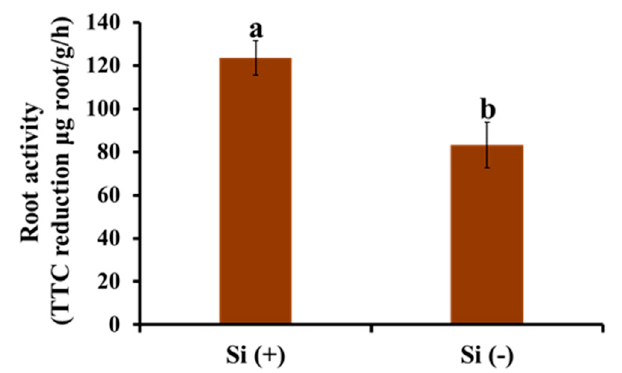
Figure 8. Effect of 30 days of silicon application on root activity in the coffee plants grown in plant growth chambers. Si (+) and Si ( − ) refer to 75 and 0 mg·L − 1 , respectively. Vertical bars indicate the means ± standard error ( n = 6). Different lowercase letters indicate the significant separation within treatments by the Duncan’s multiple range test at p ≤ 0.05.